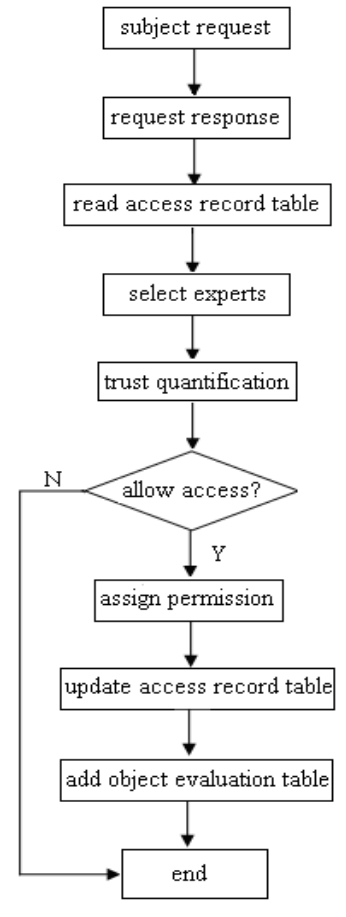
Fig. 4. Procedure for an object to use the access record table and the object evaluation